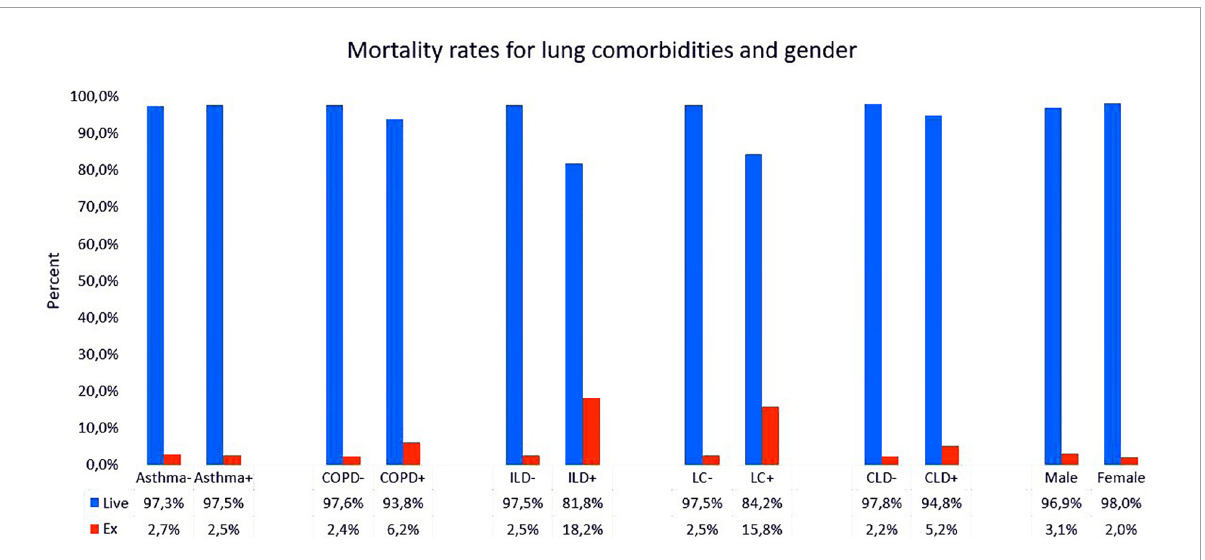
FIGURE2 Mortality rates for lung comorbidities and gender in patients with chronic disease (Group 1) and without chronic lung disease (Group 2). Abbreviations: COPD, chronic obstructive lung disease; ILD, interstitial lung disease; LC, lung cancer; CLD, chronic lung disease.